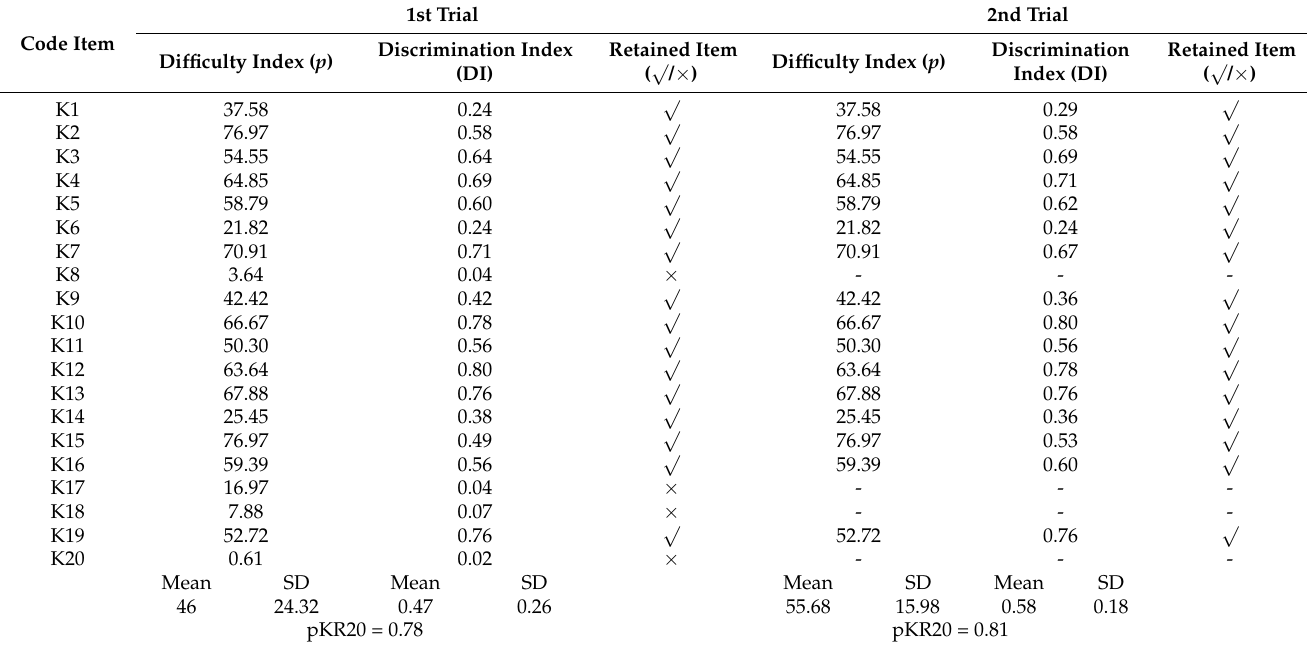
Table 2. Validity and reliability analyses for knowledge